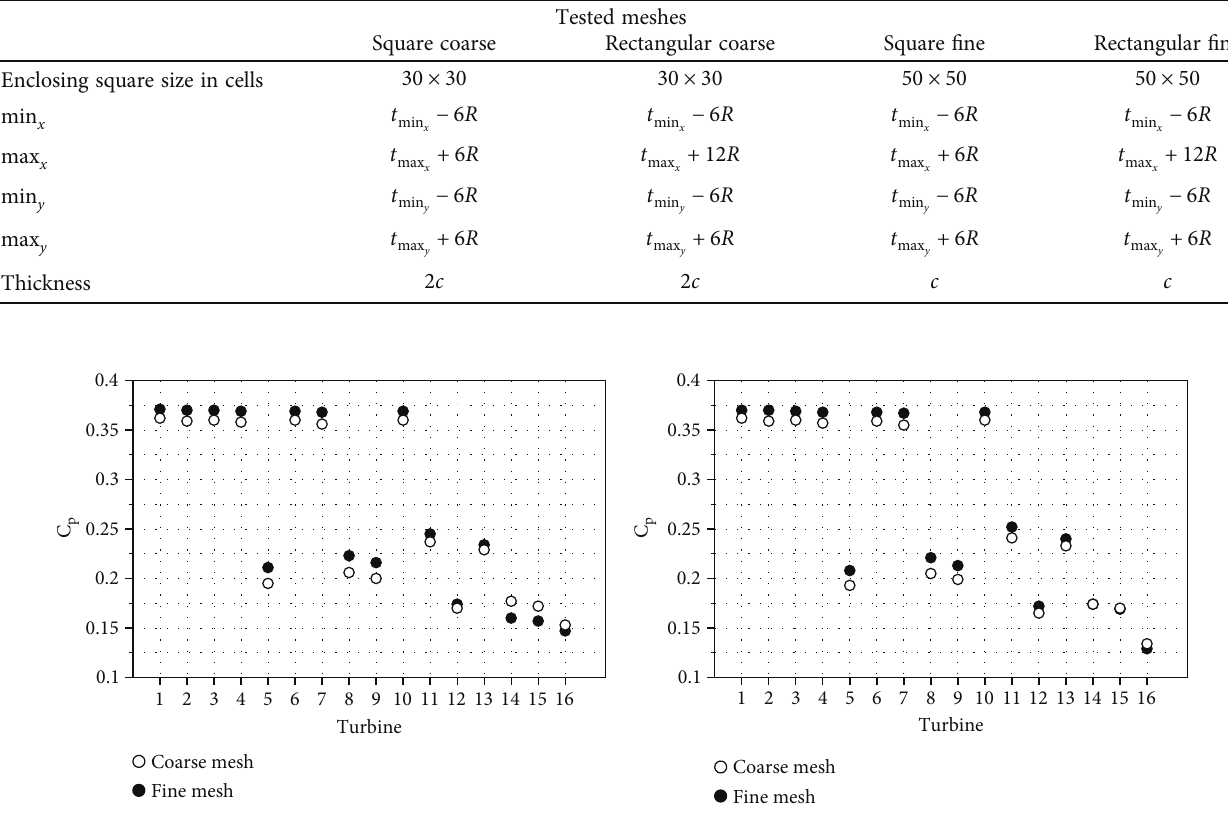
= 8 : 74 ms − 1 . t is the position of a turbine, e.g., t ∞